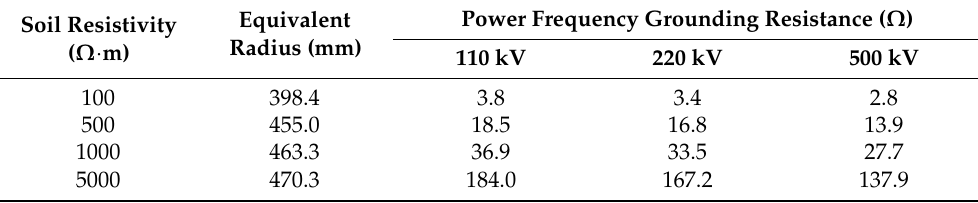
Table 8. Power frequency grounding resistance of tower foundation with four piles.